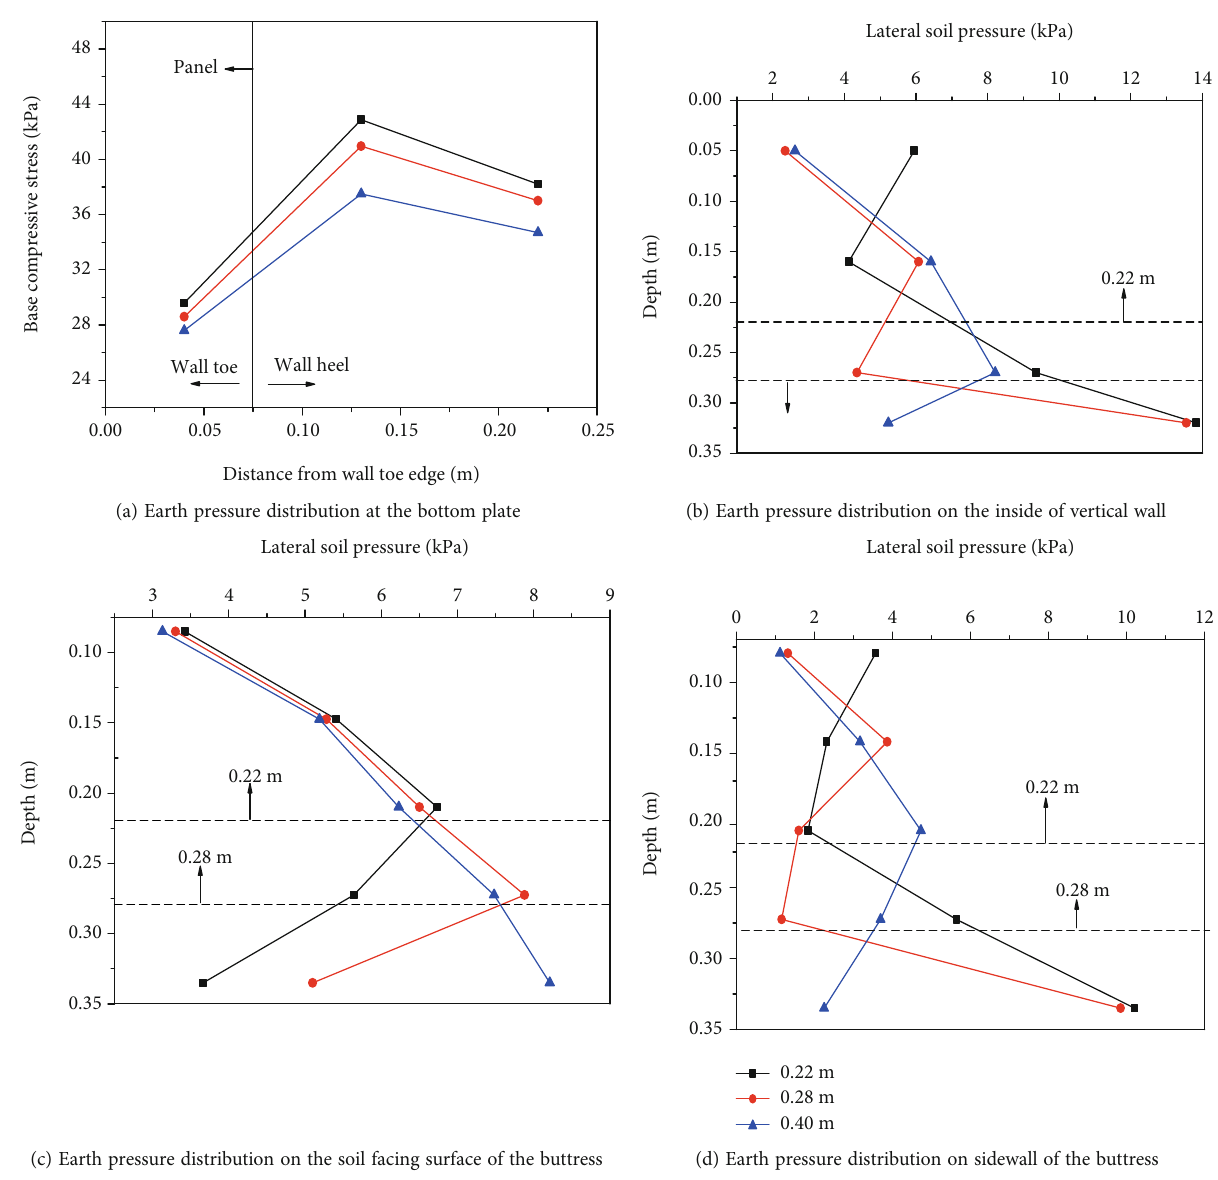
Figure 12: Earth pressure distributions of retaining wall under di ff erent replacement thicknesses of lightweight foamed